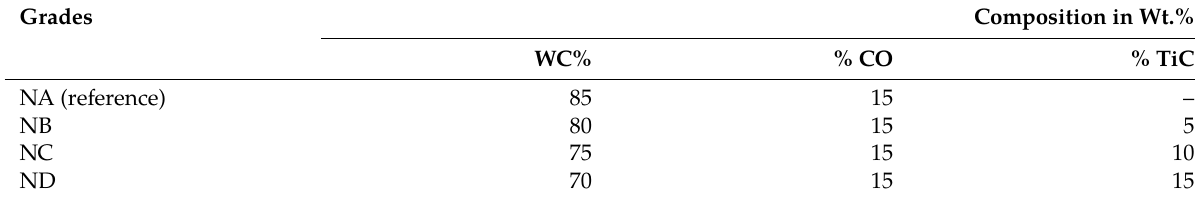
Table 1: Composition by weight of the powder mixtures of cermets. Grades Composition in